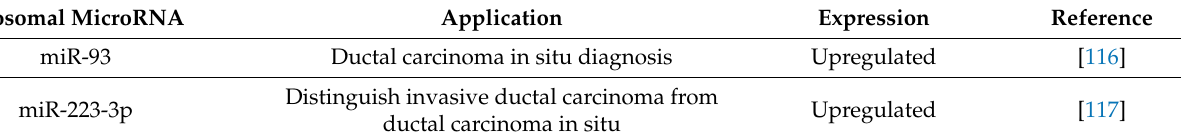
Figure 4. MicroRNAs involved in tumor dissemination. The microRNAs that have a stimulating effect on the development of the process are indicated in red, and the inhibitory effect is indicated in blue. It should be noted that comparative analysis of the levels of tumor-specific free- circulating and exosomal microRNA revealed an increased relative level of miR-101, miR- 372, and miR-373 in exosomes compared to blood serum of BC patients [115]. To date, exosomal microRNAs have been established that are significant for the diag- nosis of BC, including for the differentiation of tumor subtypes (Table 2). Table 2. Exosomal microRNA in BC